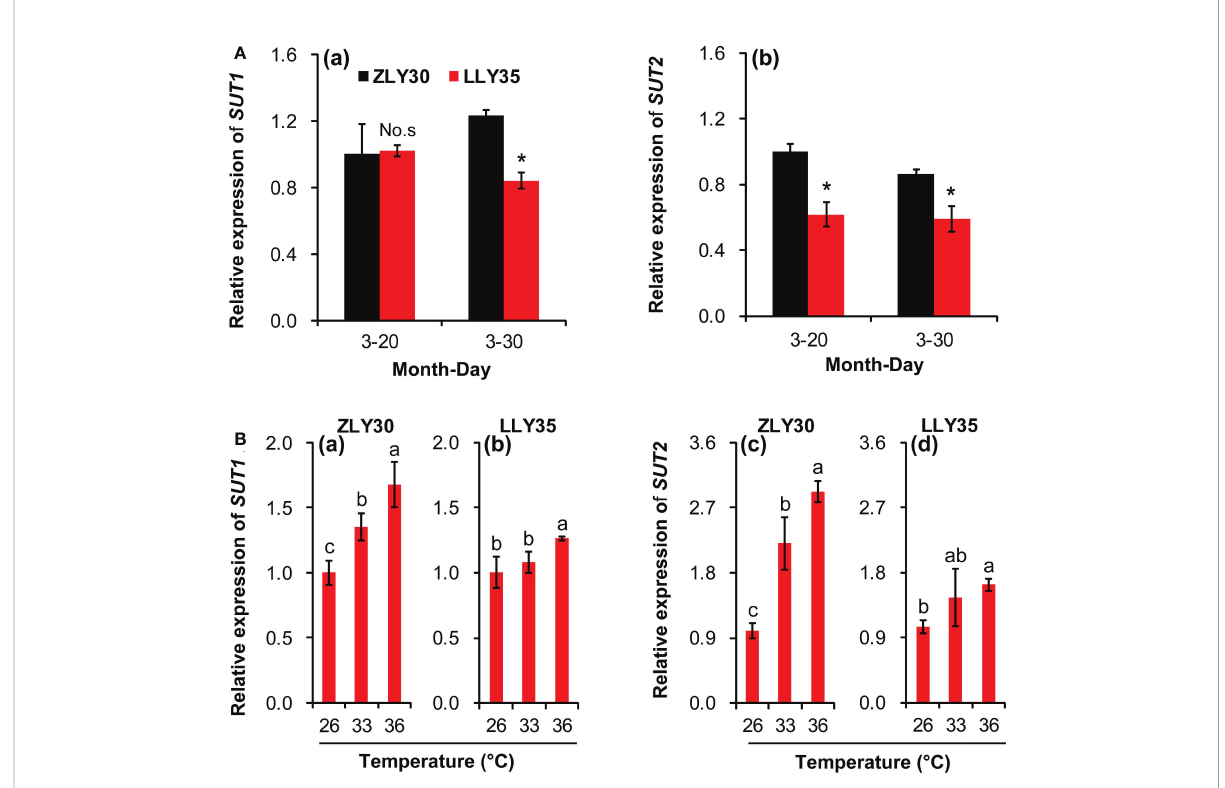
FIGURE 4 Effect of different sowing times and temperatures on relative expression levels of SUT1 and SUT2 in grains of rice. (A) Relative gene expression levels of SUT1 (a) and SUT2 (b) in ZLY30 and LLY35 at different sowing times; (B) Relative gene expression levels of of SUT1 (a, b) and SUT2 (c, d) in two cultivars under different temperatures; Vertical bars denote standard deviations ( n =3). “ * ” indicated signi fi cant difference while “ No.s ” indicate no signi fi cant difference at the 0.05 probability level between the ZLY30 and LLY35 within one sowing time using T-test